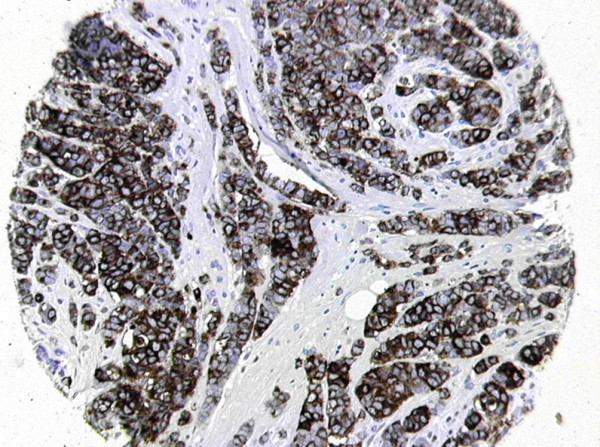
Tissue microarray core demonstrating tumour with strong Lewisy/b expression. Fourteen percent of tumours demonstrated strong expression of Lewisy/b.